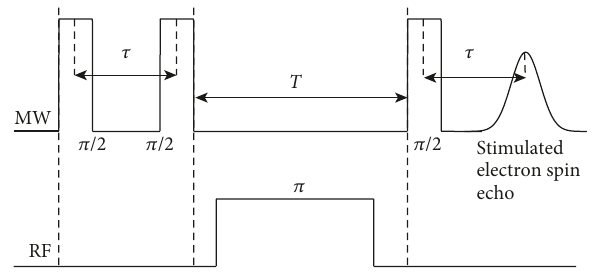
Figure 1: Mims pulse sequence at microwave and radiofrequencies used to obtain the ENDOR spectra as a function of the stimulated electron spin echo amplitude from the frequency of RF pulse. The values of time delays ( τ , T ) and pulse lengths ( π /2 for MW and π for RF) are given in the